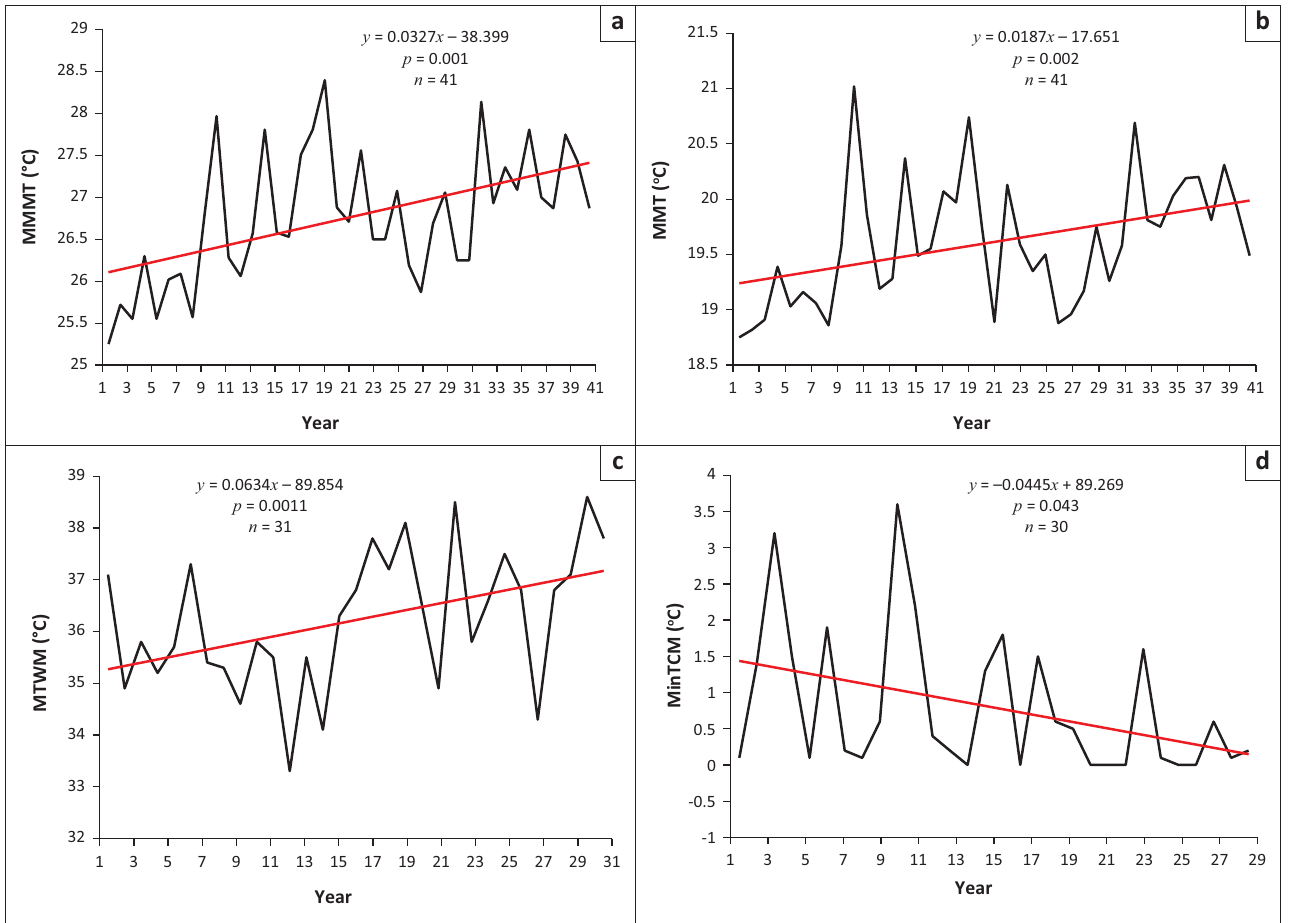
FIGURE 3: Temperature trends in Masvingo city, Zimbabwe: (a) mean monthly maximum temperatures (MMMT), (b) monthly maximum temperature (MMT), (c) maximum temperature of the warmest month (MTWM), and (d) minimum temperature of the coldest month (MinTCM).